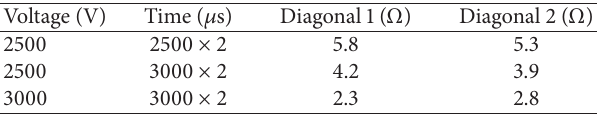
Table 1: Sintering parameters and measured resistances for anten- nas on